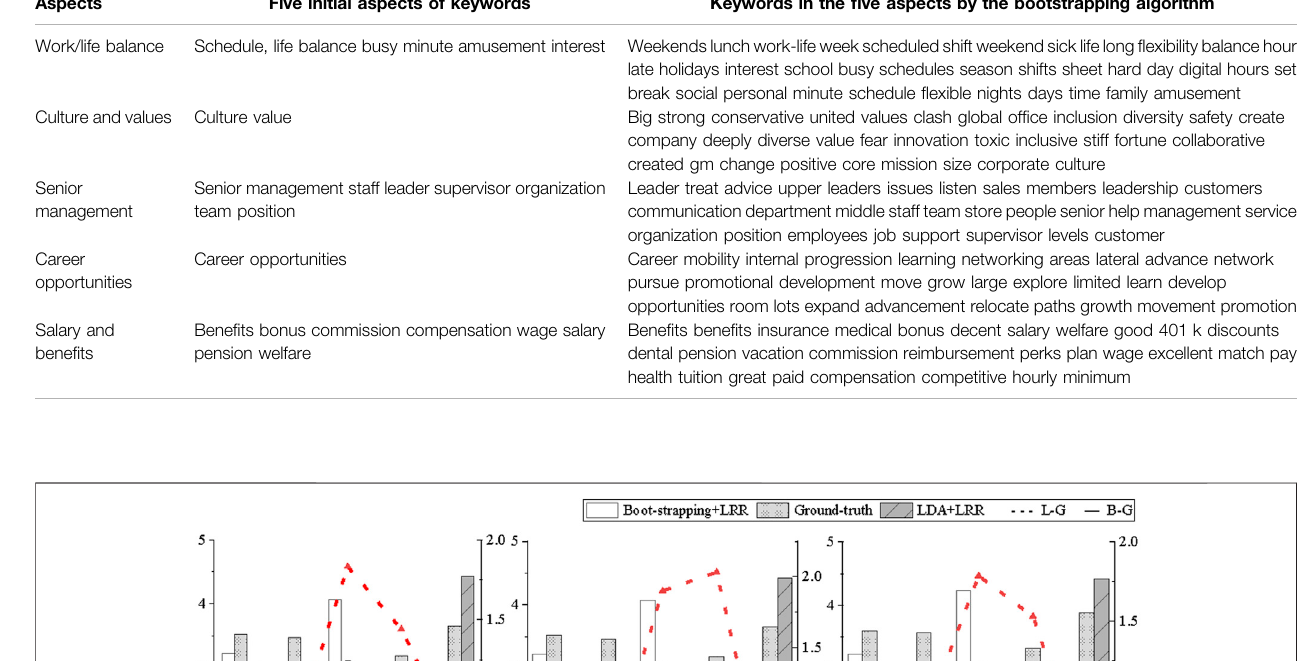
TABLE 2 | Keywords in the fi ve aspects by the bootstrapping algorithm. Aspects Five initial aspects of keywords Keywords in the fi ve aspects by the bootstrapping algorithm Work/life balance